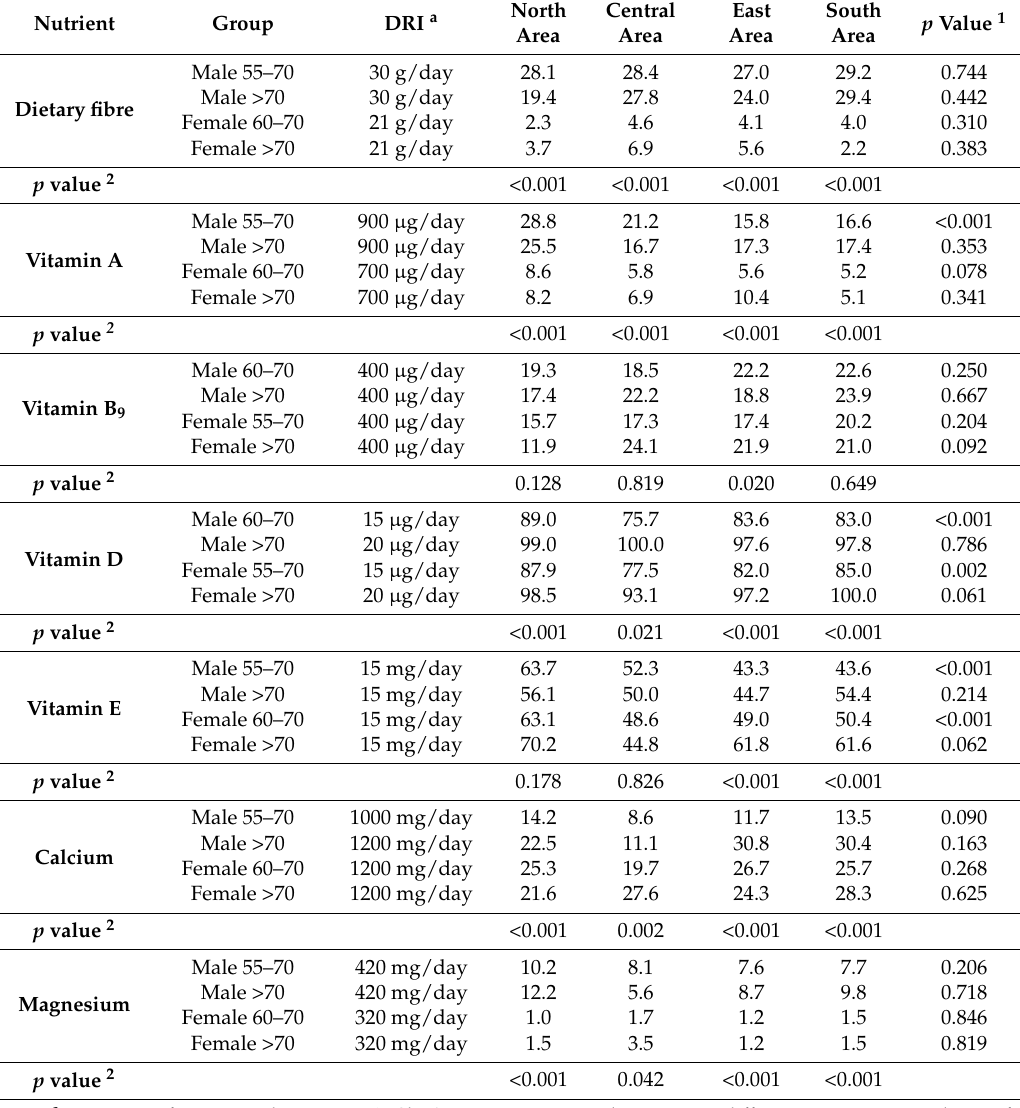
Table 3. Participants with nutrient intake below 2/3 of DRIs by geographical areas, age and sex.